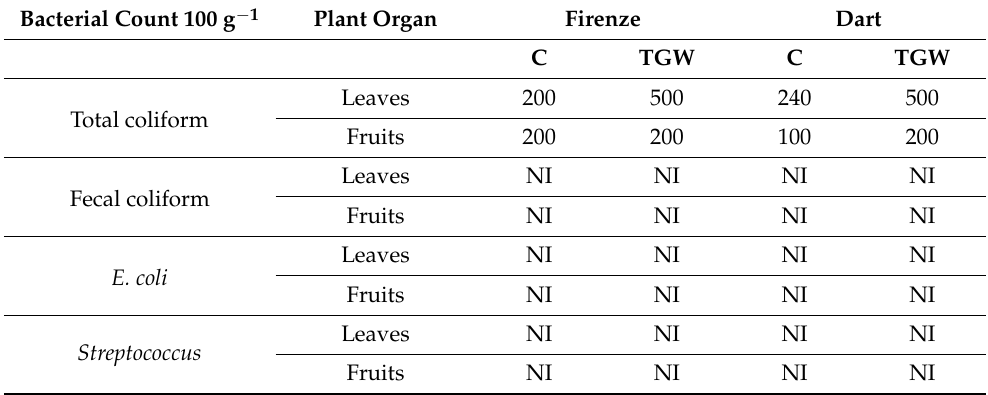
Table 5. Bacterial counts in tomato leaves and fruits under ground water (C) and treated grey water (TGW) irrigation treatments.